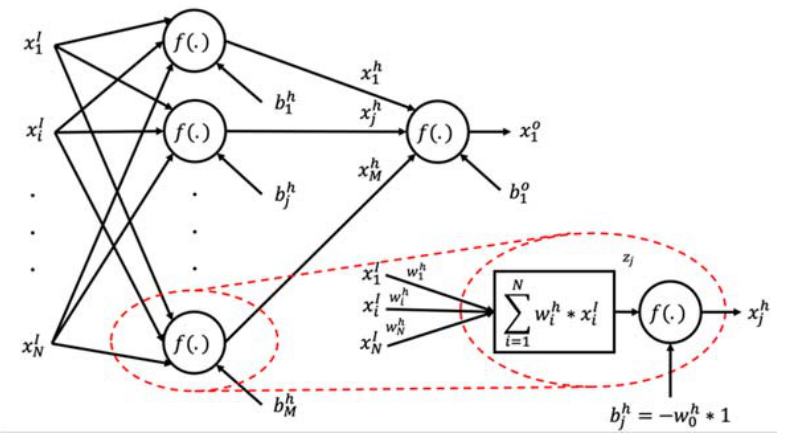
Figure 13. MLP structure.